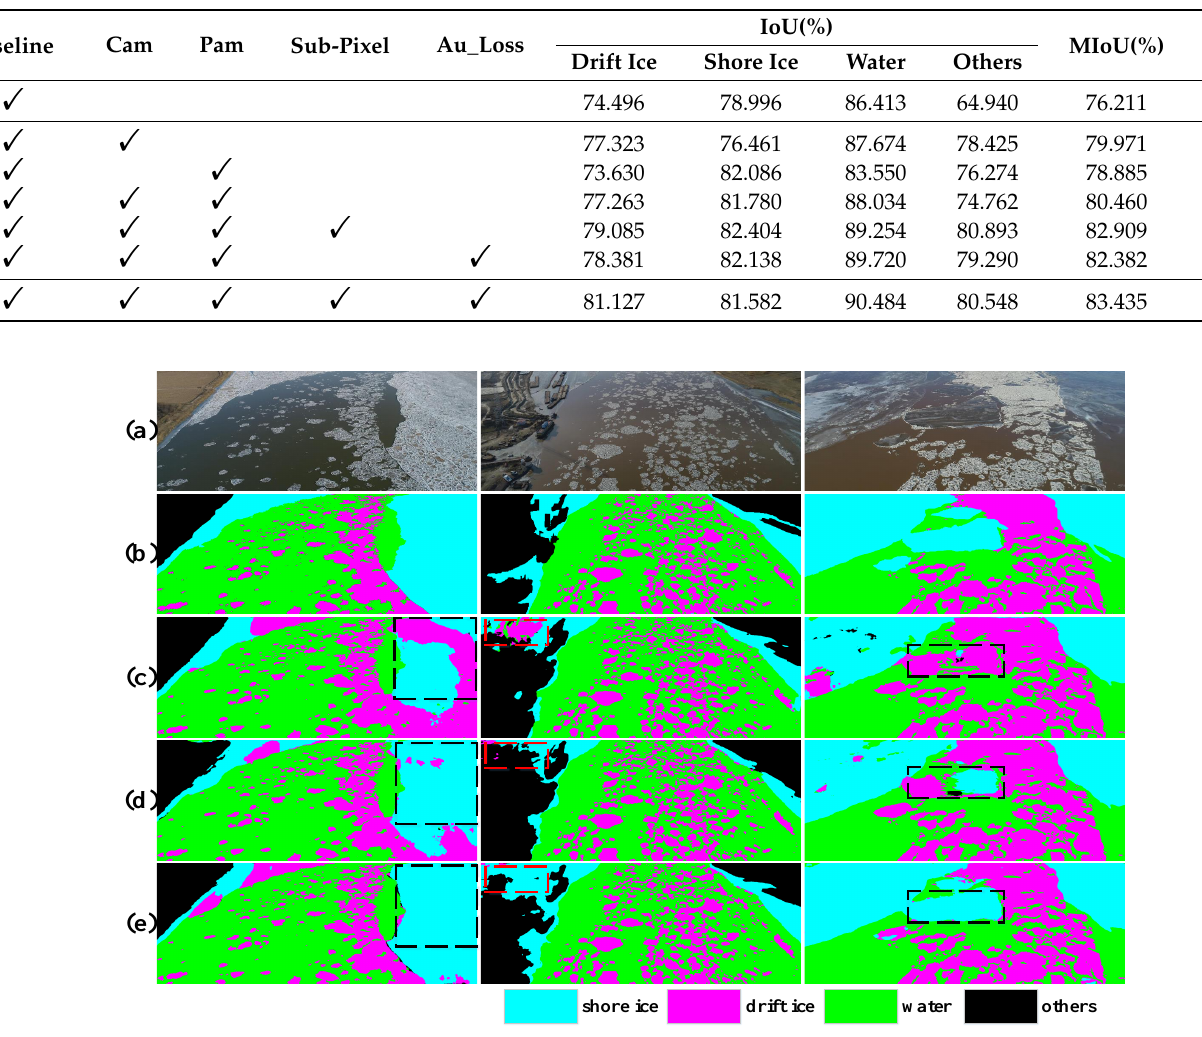
Table 4. Ablations on the channel attention module, the position attention module, the auxiliary loss, and sub-pixel up-sampling module.